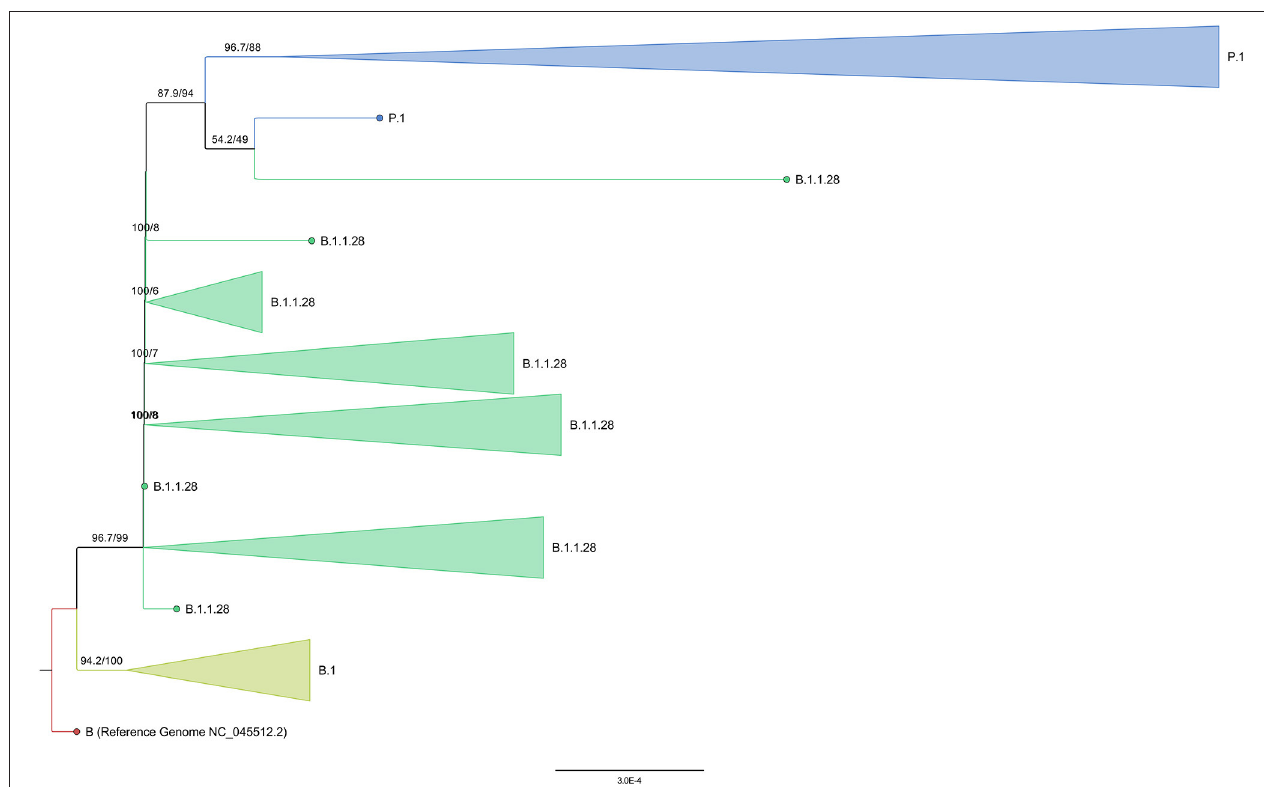
FIGURE 6 | Collapsed tree representing the assigned lineages of the 4,997 subsampled genomes from global